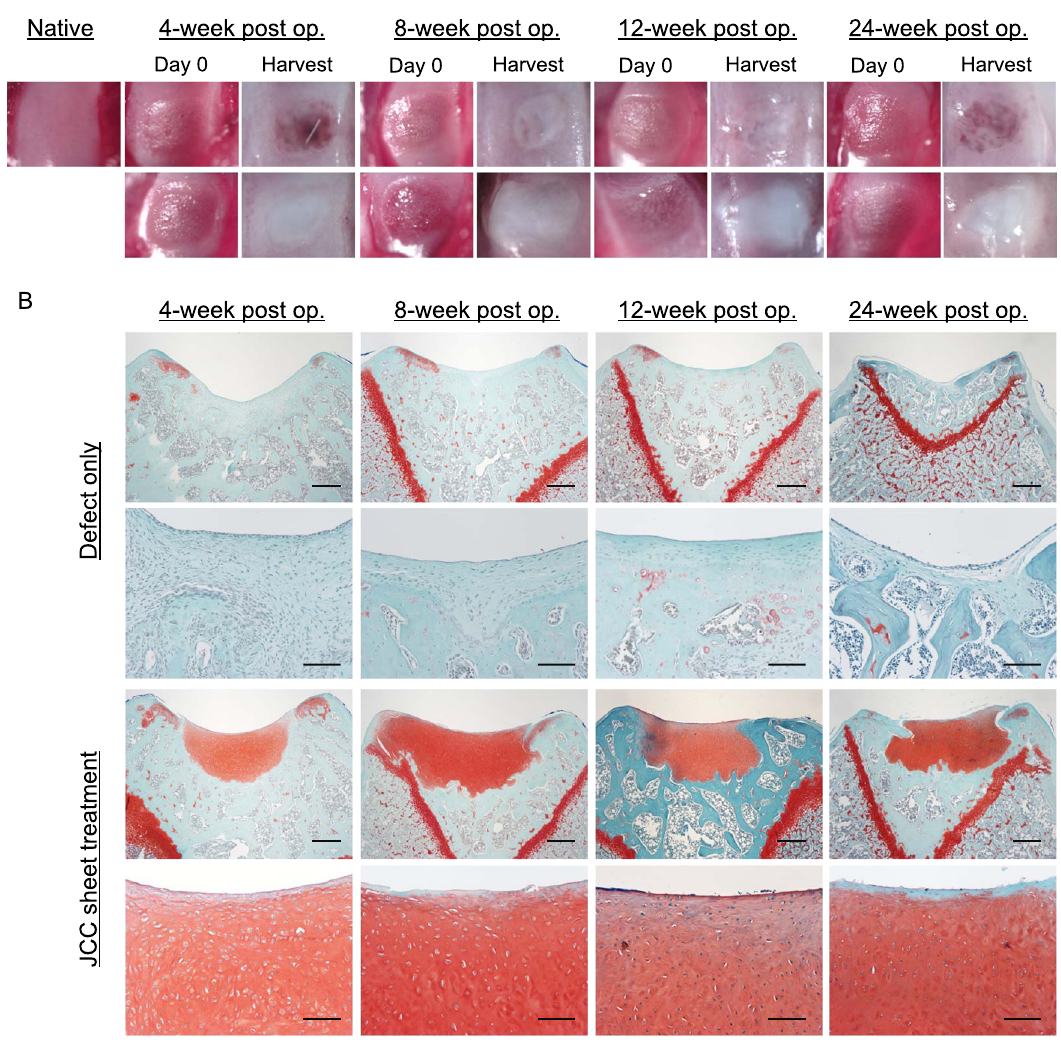
Fig. 4 Middle- and long-term in vivo ef fi cacy of focal osteochondral defect treatment in nude rats. A Macroscopic images of surgically created focal defects (left images of each group) and 4, 8, 12, and 24 weeks after treatments (right images of each time point). The top row shows native and defect only group. The bottom row shows defect and cell sheet group. B Safranin-O staining of each condition. Representative images of samples at 4 weeks ( n = 14), 8 weeks ( n = 3), 12 weeks ( n = 3), and 24 weeks ( n = 3) are shown. Bars: Top and third rows: 500 µm, second and bottom rows: 100